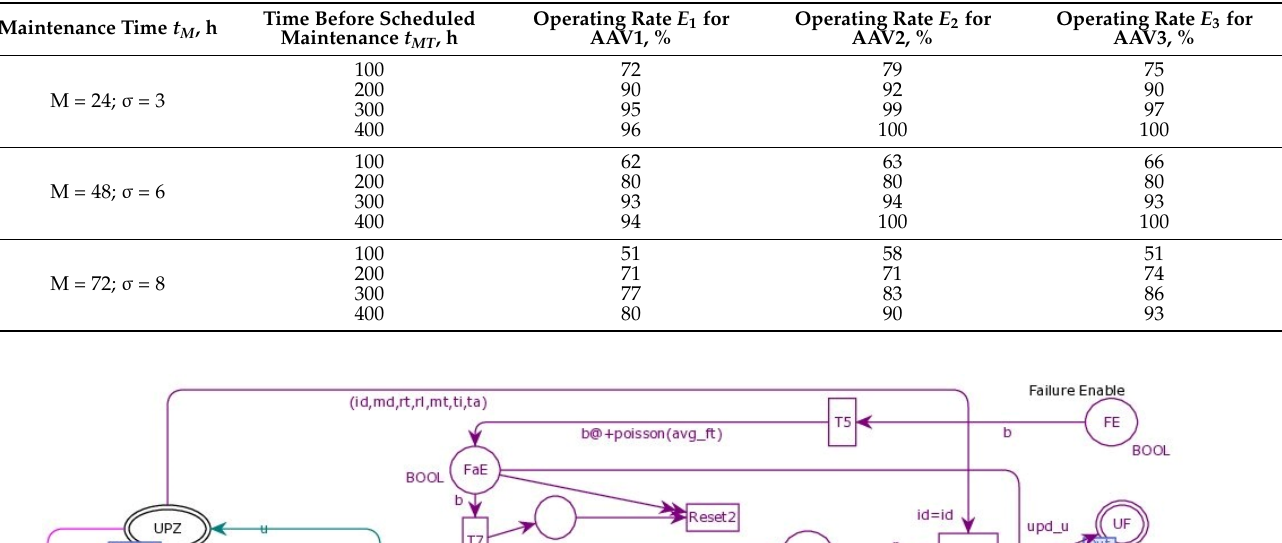
Table A5. AAV use assessment.